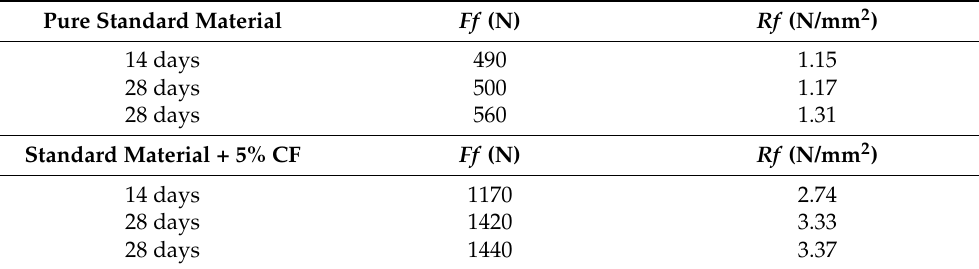
Table 3. Flexural strengths ( Rf ) at the fracture point obtained of the standard pure material and doped bentonitic grout (+5% of carbon fiber). Ff is the strength applied at the center of prismatic samples. Pure Standard Material